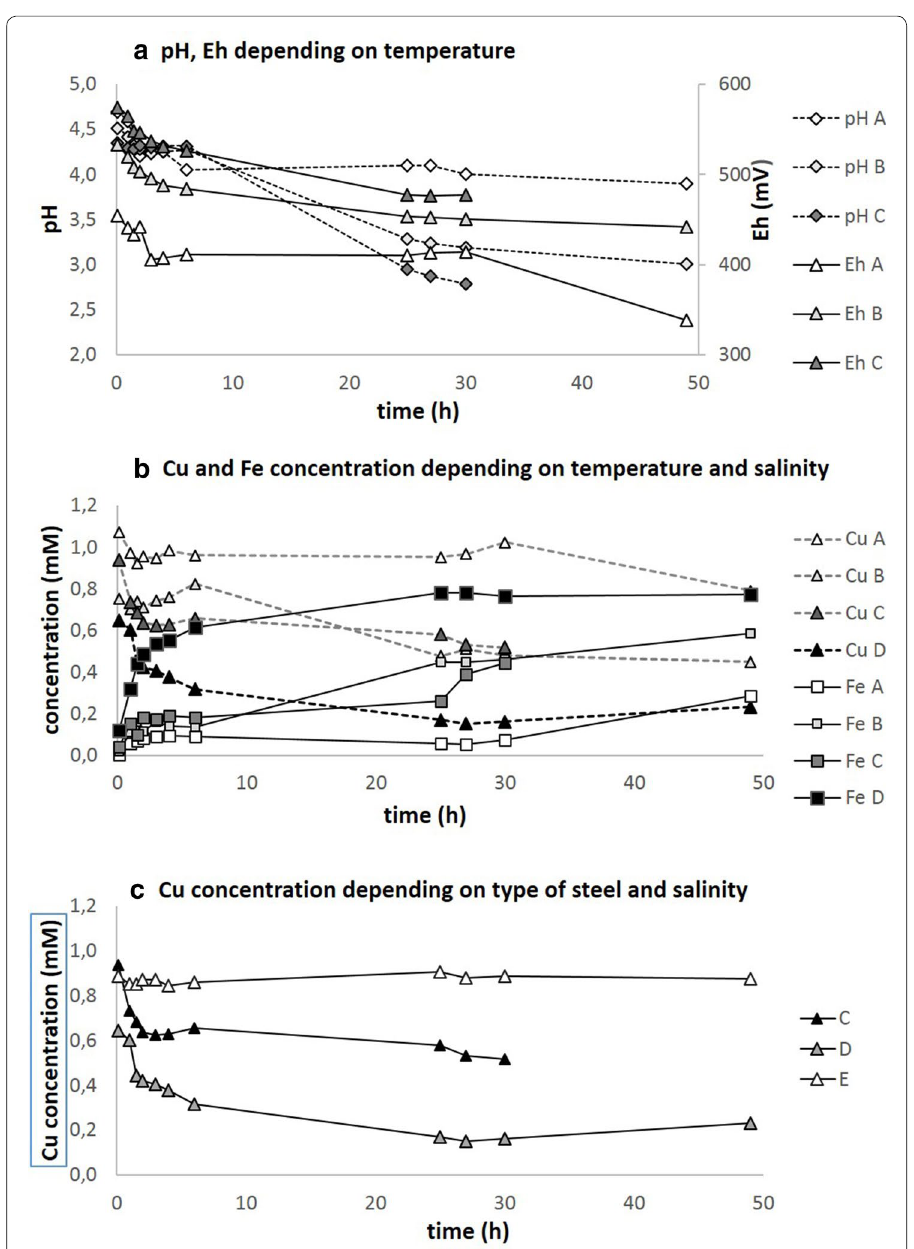
Fig. 3 Measured solution parameters in experiments A – E . a Eh and pH values at 25 ( A ), 50 ( B ), and 80 ( C ) °C in the collection container. b Cu and Fe concentrations measured over time in samples from the sampling line. c Cu concentration at 80 °C experiments in brine collected from the sampling line ( C ); in deionized water ( D ); in brine with stainless steel capillary ( E ). Details on experiments A , B , C , D , E are explained in Table